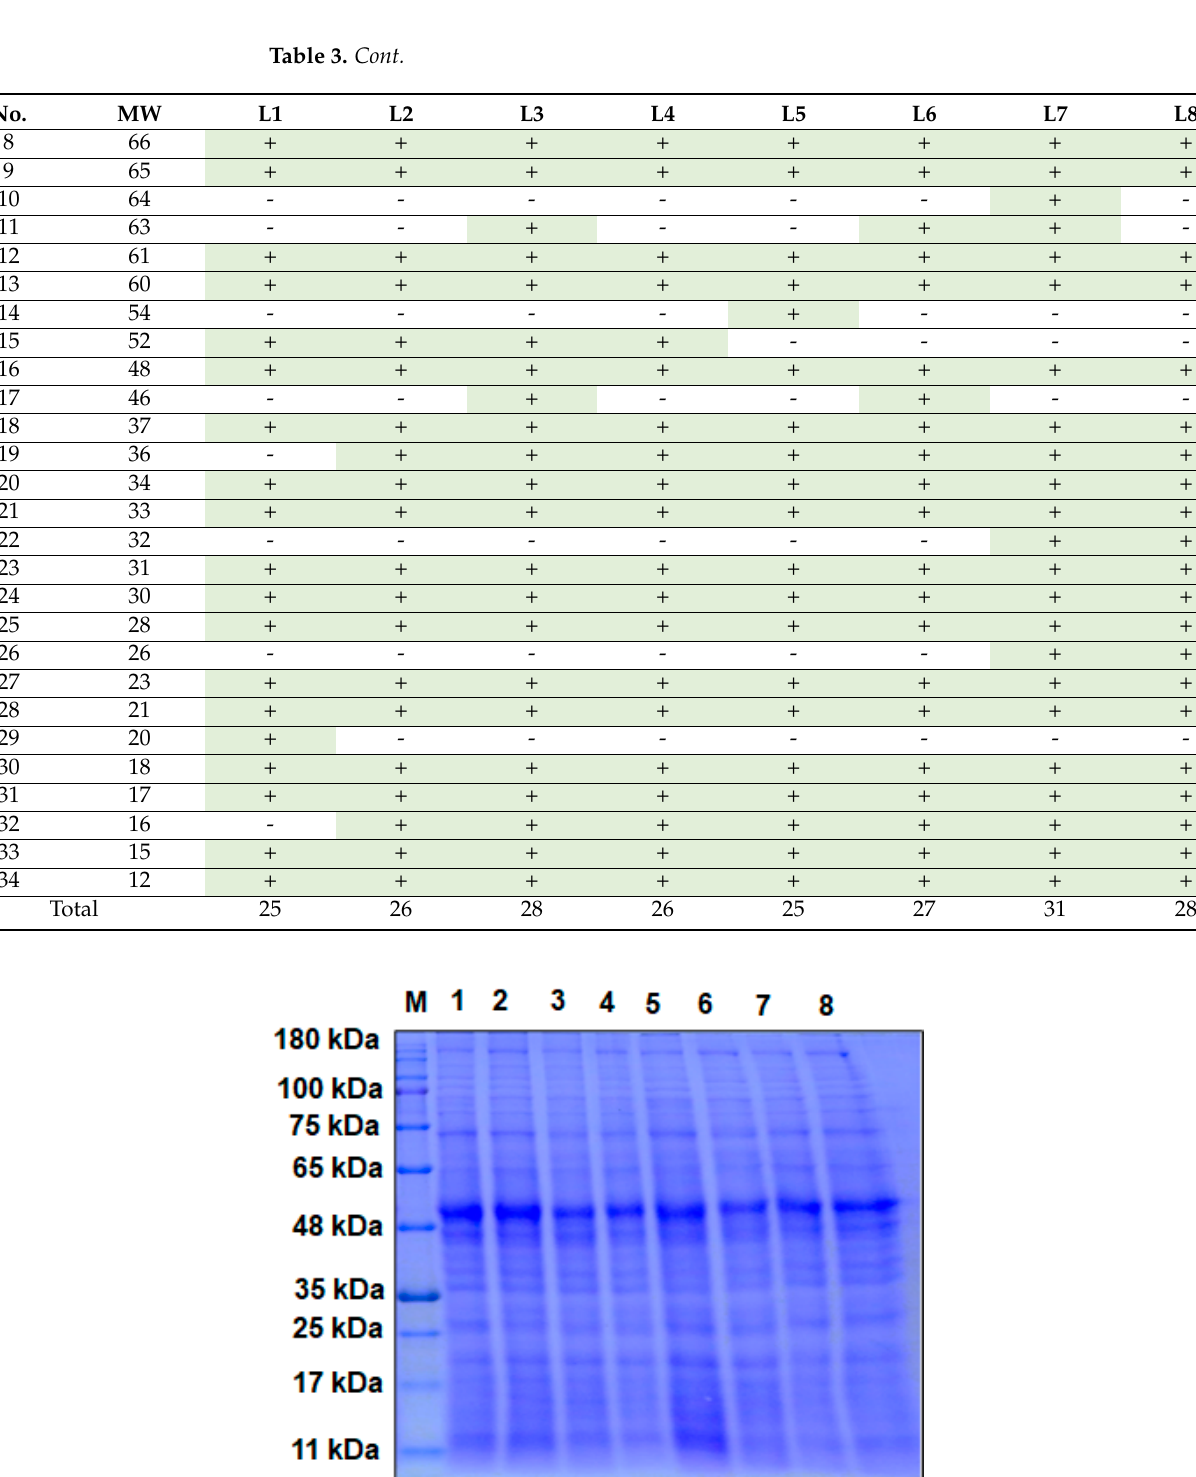
Figure 4. Change in protein pattern in putrescine-pretreated wheat plants under water deficit condition. L1, control; L2, 0.25 mM putrescine; L3, 0.5 mM putrescine; L4, 1 mM putrescine; L5, water deficit conditions; L6, water deficit condition combined with 0.25 mM putrescine; L7, water deficit condition combined with 0.5 mM putrescine; L8, water deficit condition combined with 1mM putrescine.